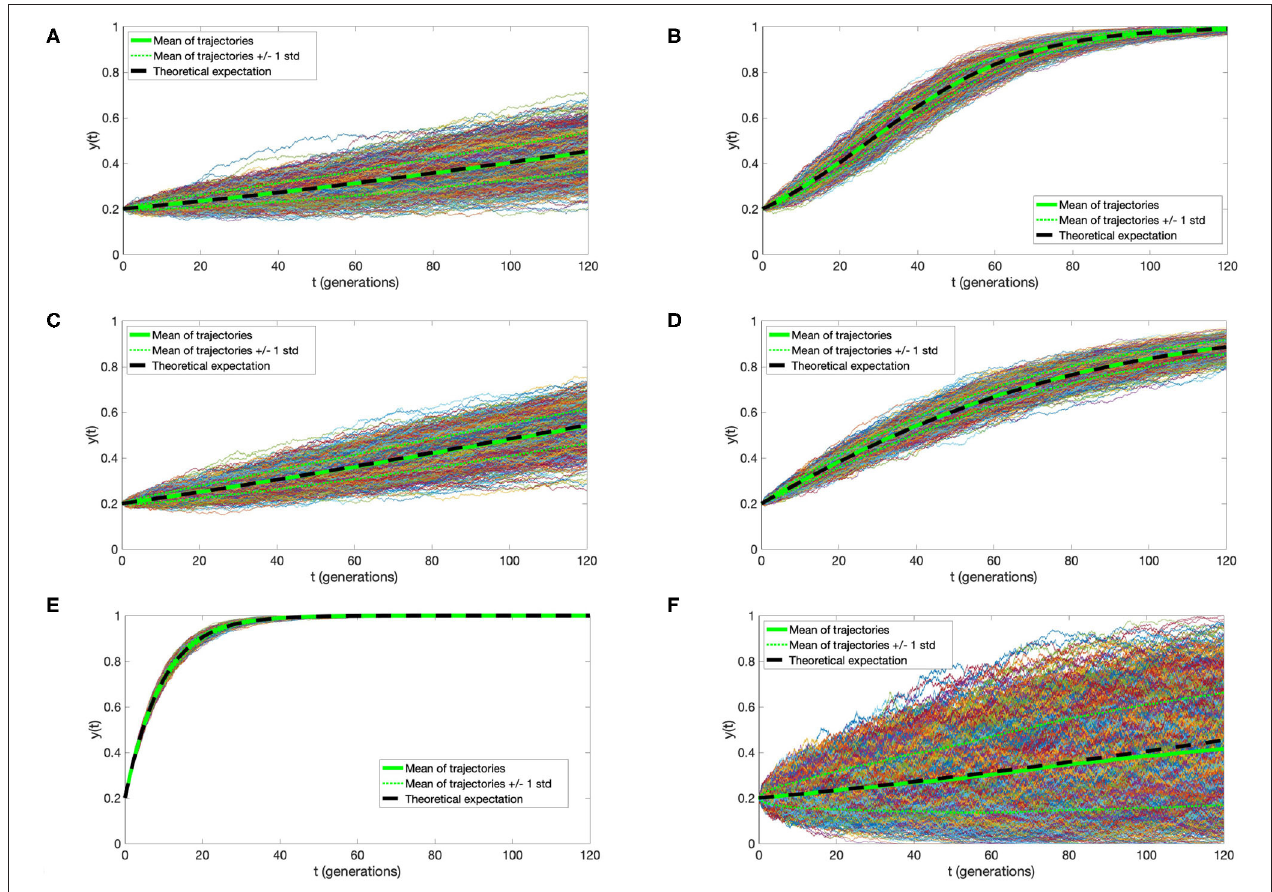
FIGURE 2 | Trajectories of the Moran process with directional selection and recurrent mutation. One thousand simulations were plotted, with thicker green line denoting their mean, thinner green lines mean ± standard deviation, and black dashed line the solution of Equation (4). Parameter values (A) s = 0.01, µ = 0.000001, (B) s = 0.05, µ = 0.000001, (C) s = 0.01, µ = 0.001, (D) s = 0.01, µ = 0.01, (E) s = 0.01, µ = 0.1; and N = 10000, t 0 = 0, y 0 = 0.2 in (A–E) . (F) For comparison, trajectories under s = 0.01, µ = 0.1 as in (A) , but with N = 1,000 are depicted, illustrating the impact of the cell count on variance of the process. In all panels, time is expressed in average cell generation units, µ in inverse time units, and s is